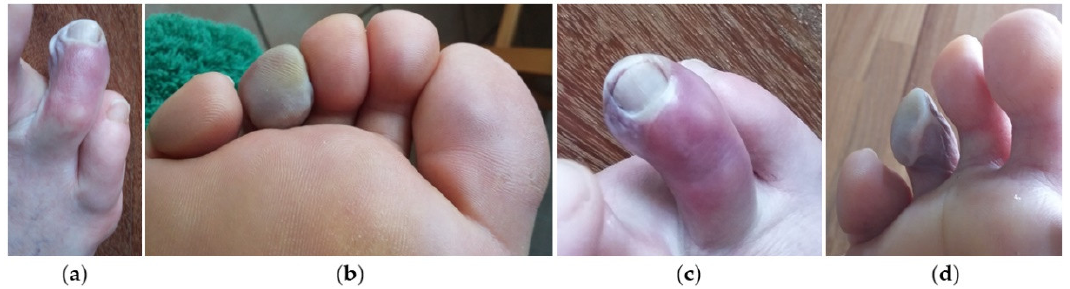
Figure 2. Plantar and dorsal view of skin conditions with progressive ischemia of the fourth toe after USGAI. Clinical images at 10 days ( a , b ) and 20 days ( c , d ) from the procedure.